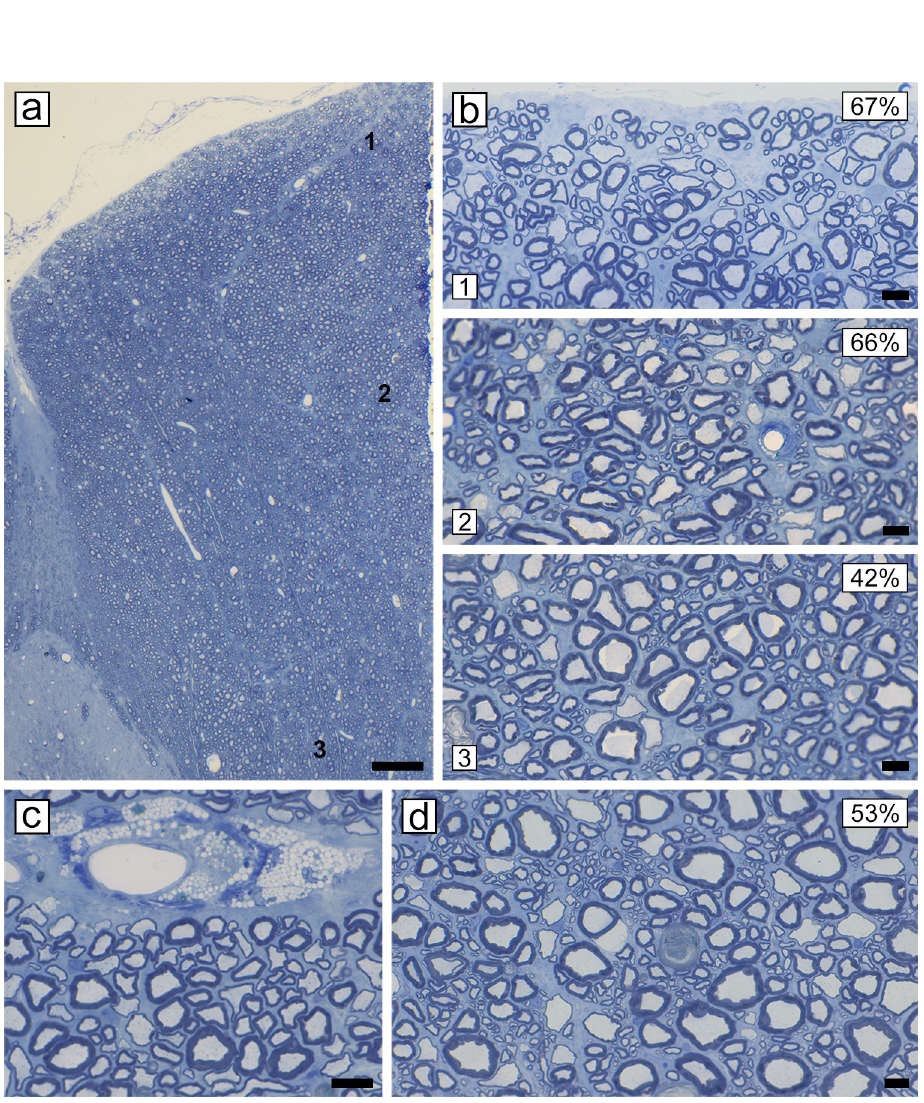
Fig 9. Both demyelination and remyelination are seen throughout the brain. During acute disease, myelin vacuolation and subsequent demyelination occur in many white matter areas of the brain including the internal capsule (a) and subcortical white matter (b) . On recovery there is extensive remyelination of these structures and of the corpus callosum. The splenium of the normal corpus callosum contains mainly small diameter and some medium diameter myelinated axons with normal thickness myelin sheaths (c) . In the same area of the corpus callosum in a recovered cat there is a preponderance of thin myelin sheaths (remyelinated), adjacent to a blood vessel surrounded by foamy macrophages, identifying this as a site of previous demyelination (d) . Remyelination was also notable in the internal capsule, sub-cortical white matter, crus cerebri, and cerebellum (e-i) . Occasional axons with thick myelin sheaths represent those that had not been demyelinated. Crus cerebri (Crus c.), Cerebellum (Cer.), Internal capsule (Int. Caps.), Sub-cortical white matter (SCWM). Scale bar: 200 μ m (a, b), 20 μ m (c-i).